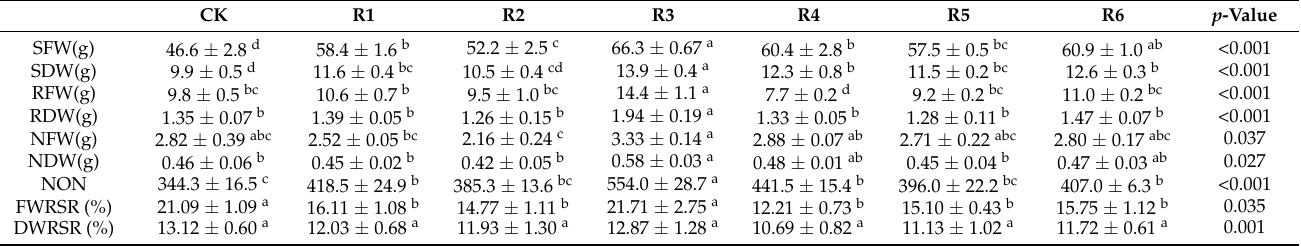
Table 2. Effects of rhizobia inoculation on the root system of D. intortum .